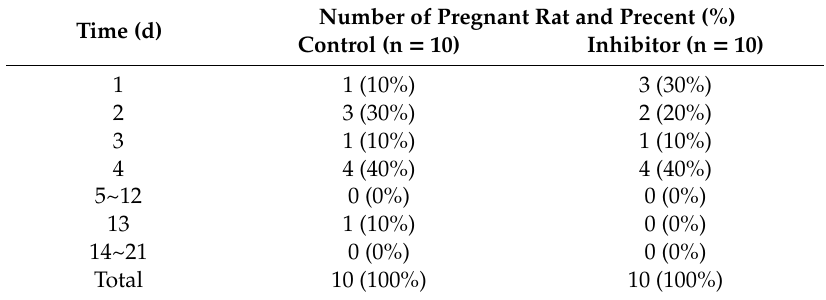
Table 3. Effects of GABA-T inhibitor treatment on distribution of time of conception in rats during 21 d mating period.